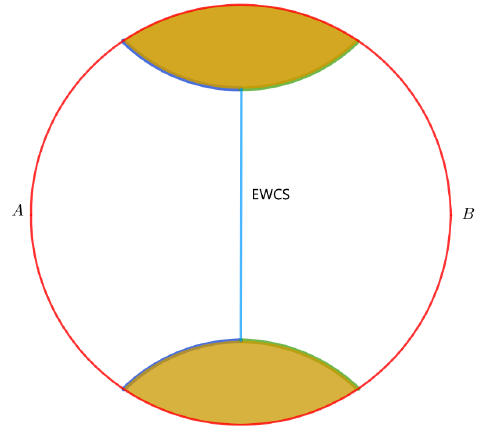
Figure 2 . The unshaded region represents the entanglement wedge of the interval A ∪ B . (Adapted from